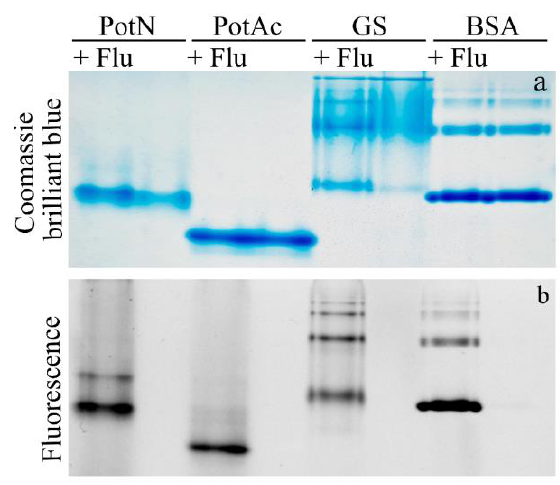
Figure 8. Basic native-PAGE of NHS-Ph-BODIPY -labeled (+ Flu) and unlabeled PotN (MW = 13.7 kDa, pI = 6.6), PotAc (MW = 18.1 kDa, pI = 5.9), GS (MW = 50.3 kDa, pI = 5.1), and BSA (MW = 66.2 kDa, pI = 5.9) visualized with Coomassie brilliant blue ( a ) and using UV transillumination ( b ) (each lane contains 10 µg of protein).